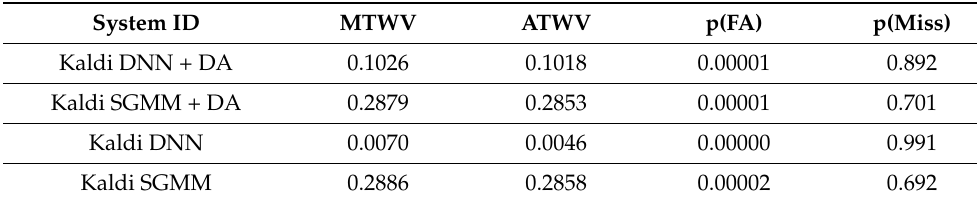
Table 9. System results of the STD task for RTVE development data.